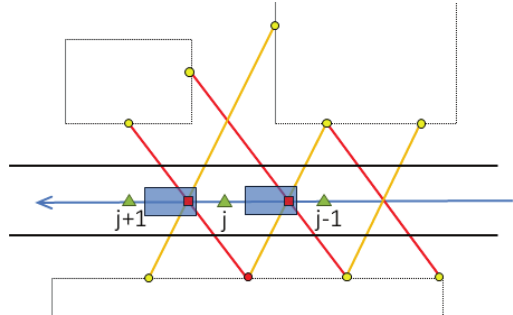
Figure 5. Influence of one object (red dot) on three anchor points (j-1, j, j+1, green triangles) on trajectory (blue arrow) with two vehicle positions (blue rectangles). The object is visible from scanner 1 (red line) and has influence on translation t j and t j+1 and from scanner 2 (orange line) with influence on t j-1 and t j